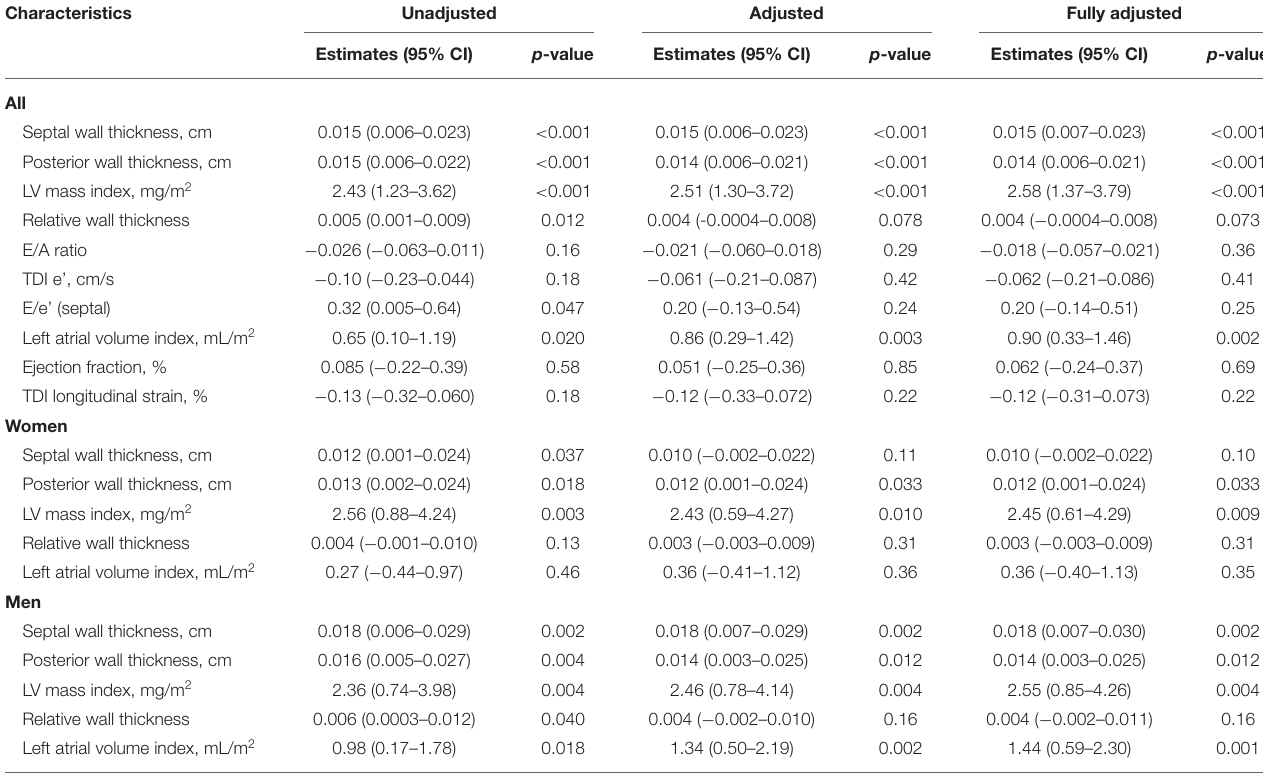
TABLE 2 | Baseline cardiac structure and function in relation to the urine microalbumin/creatinine ratio.